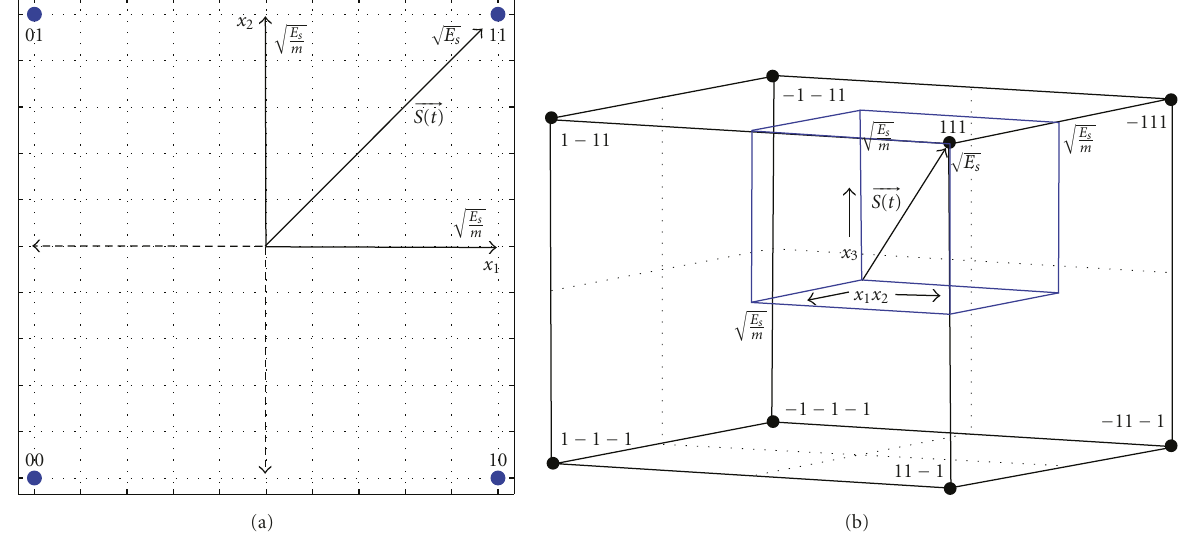
Figure 5: Signal space representation of the new modulation scheme with M = 4 and M = 8.